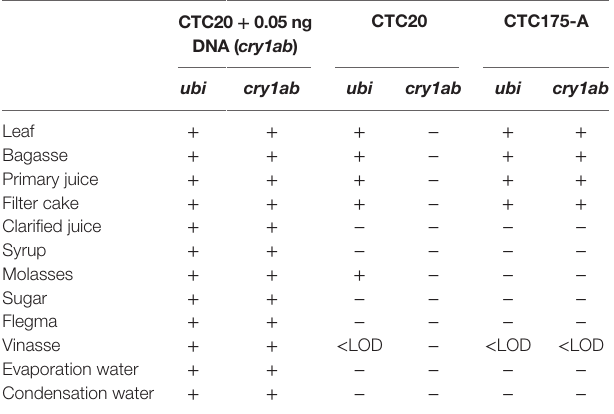
TaBle 8 | Results of gene amplification of ubi (endogenous gene) and cry1Ab in samples collected during the laboratory sugarcane processing to produce sugar and ethanol from CTC20 and